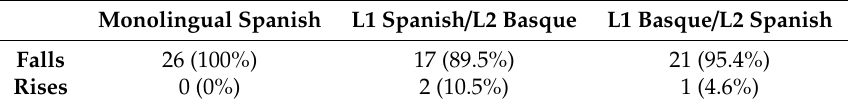
Table 3. Numbers and percentages of information-seeking yes / no interrogatives with rising–falling and rising final contours (Falls and Rises, respectively) for each linguistic profile in the town of Lekeitio.